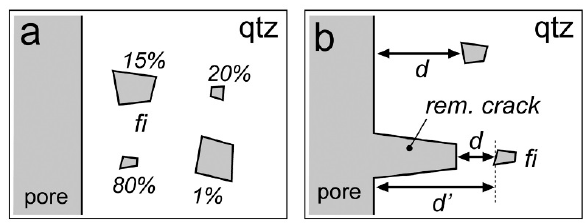
Figure 12. ( a ) Schematic drawing of D 2 O concentrations in synthetic fluid inclusion as a function of size and depth according to classical diffusion models; numbers are mole% D 2 O; ( b ) overestimation of the distance of the quartz surface to fluid inclusions ( fi ), if the remaining open crack is neglected (cf. distance d with d ’).